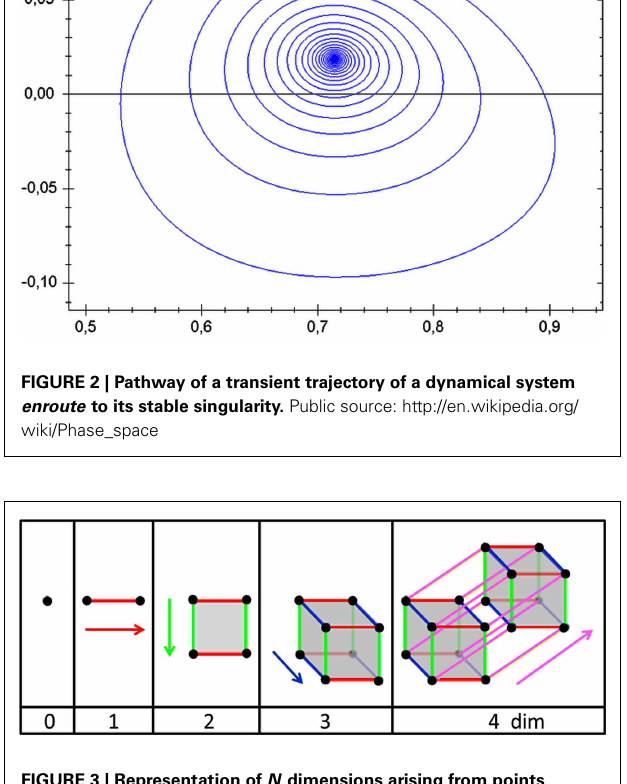
FIGURE 3 | Representation of N dimensions arising from points moving in orthogonal directions. Adapted from public source: